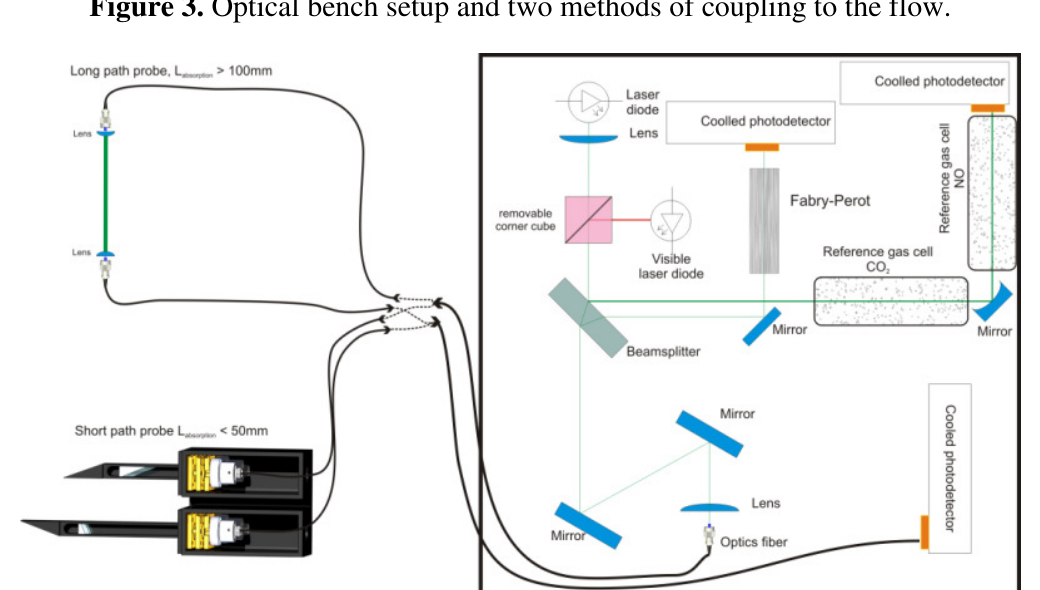
Figure 3. Optical bench setup and two methods of coupling to the